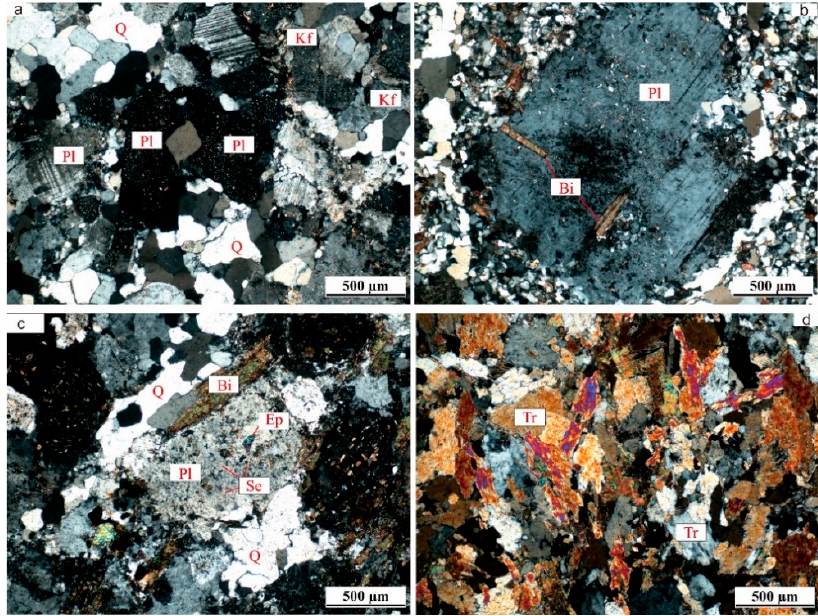
Figure 3. Photomicrographs of the tonalite–trondhjemite–granodiorite (TTG) gneiss and biotite–tremolite schist in the Northern Kongling Terrane. ( a ) Sample D0002-2; ( b ) Sample SMK-1; ( c ) Sample D0002-4; and ( d ) Sample D0002-1.